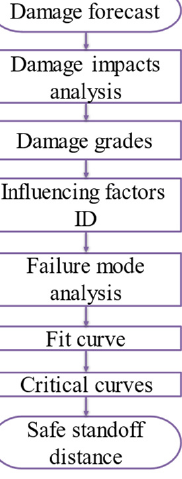
Figure 26. Flow chart for creating a damage prediction model for a concrete arch dam subjected to an underwater explosion impact.